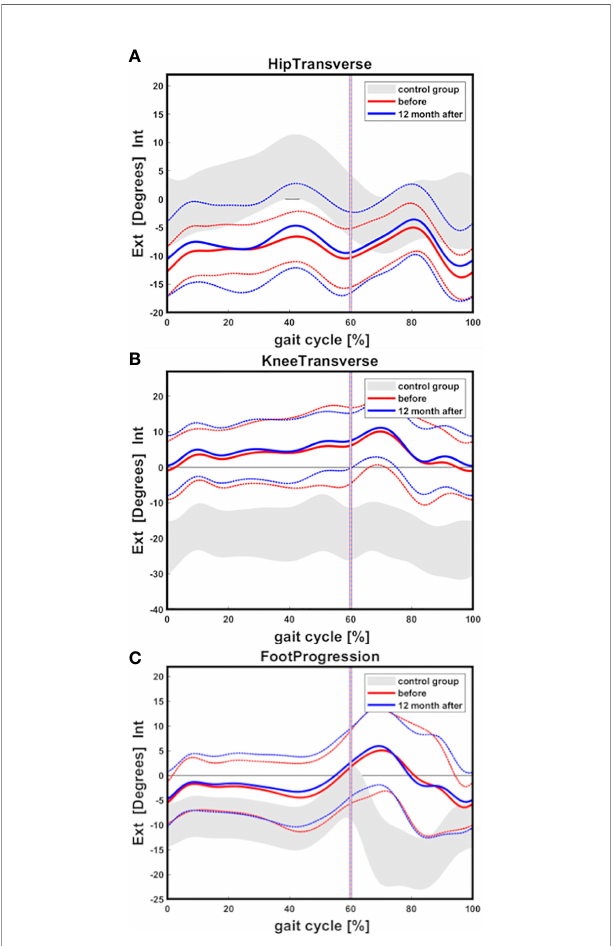
FIGURE 2 | Gait cycle analysis showing overall external hip rotation of children with XLH (n=14 legs) prior to Burosumab (red line) and 12 months after start of Burosumab (blue line) compared to a pediatric control group (gray area) (A) . Internal knee rotation (B) and internal foot progression (C) was observed. Mean value and one standard deviation (dashed line) are presented. Control group band is presented as +/-one standard